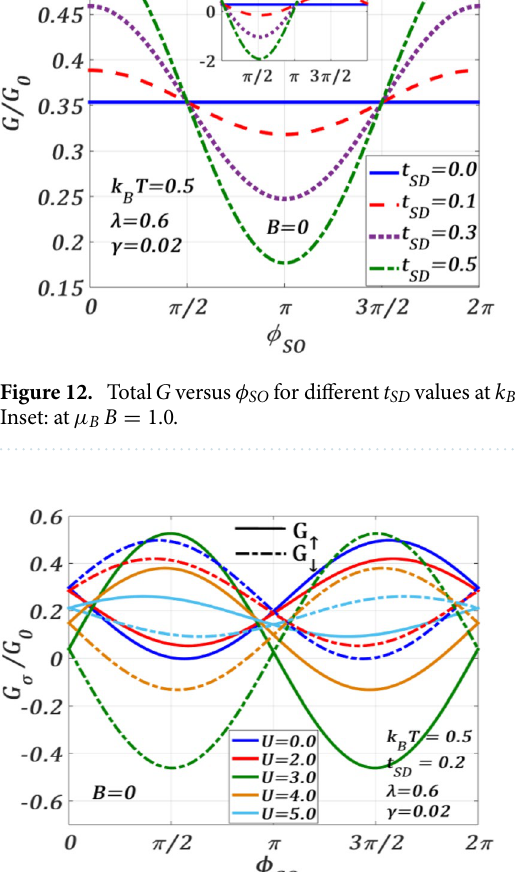
0.2, γ 0.02, (cid:31) 0.6, eV b = = =